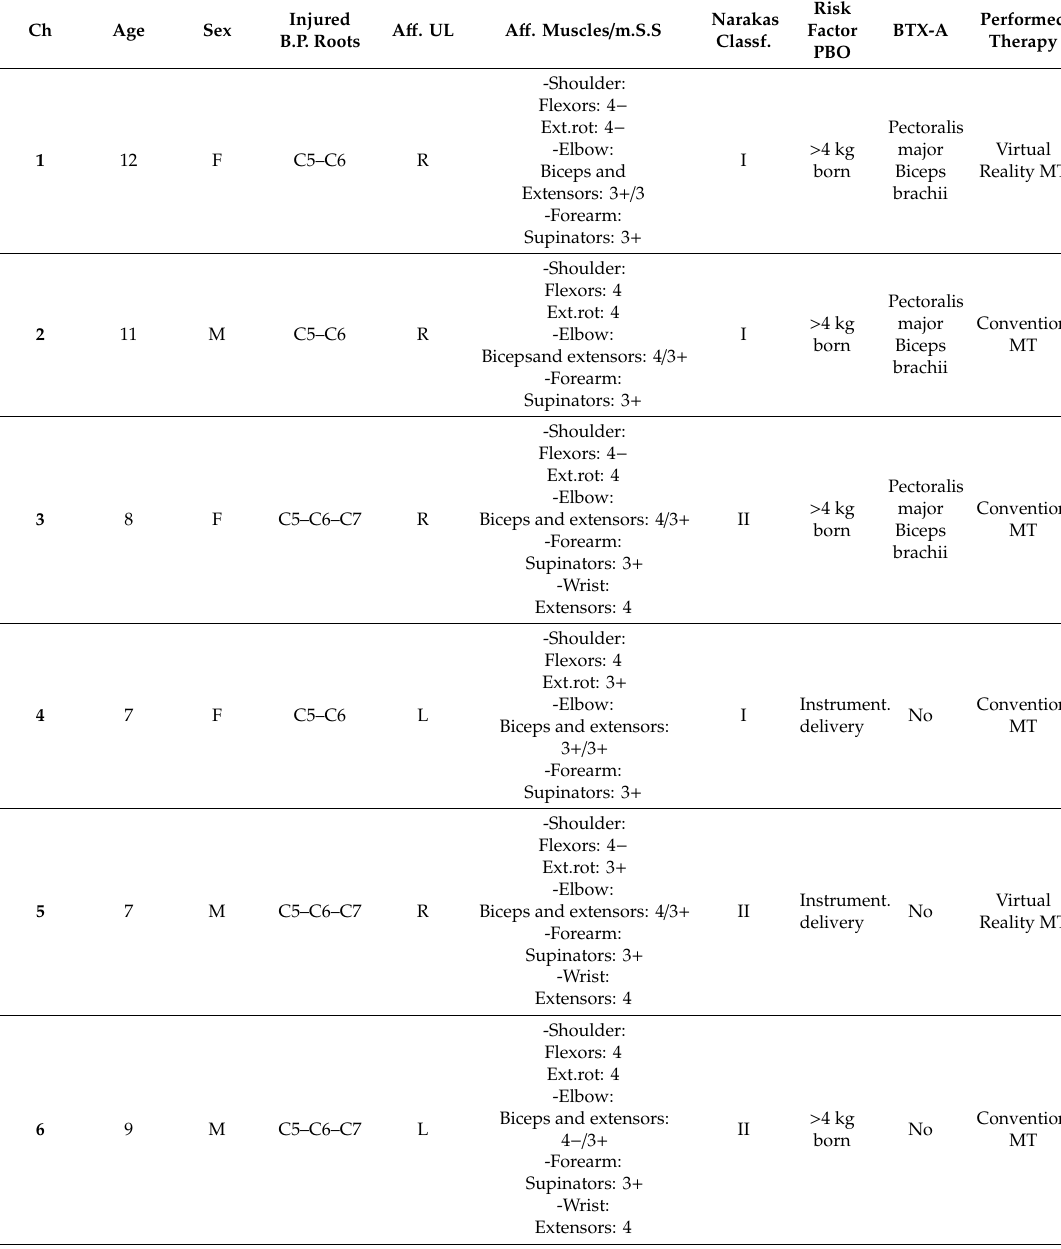
Table 4. Individual characteristics of the